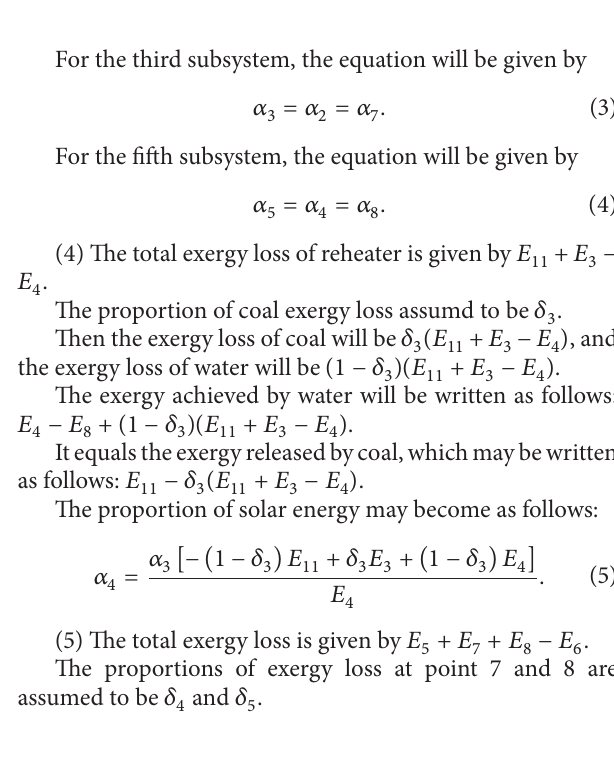
Figure 2: Schematic representation of the calculating process of the thermoeconomic cost